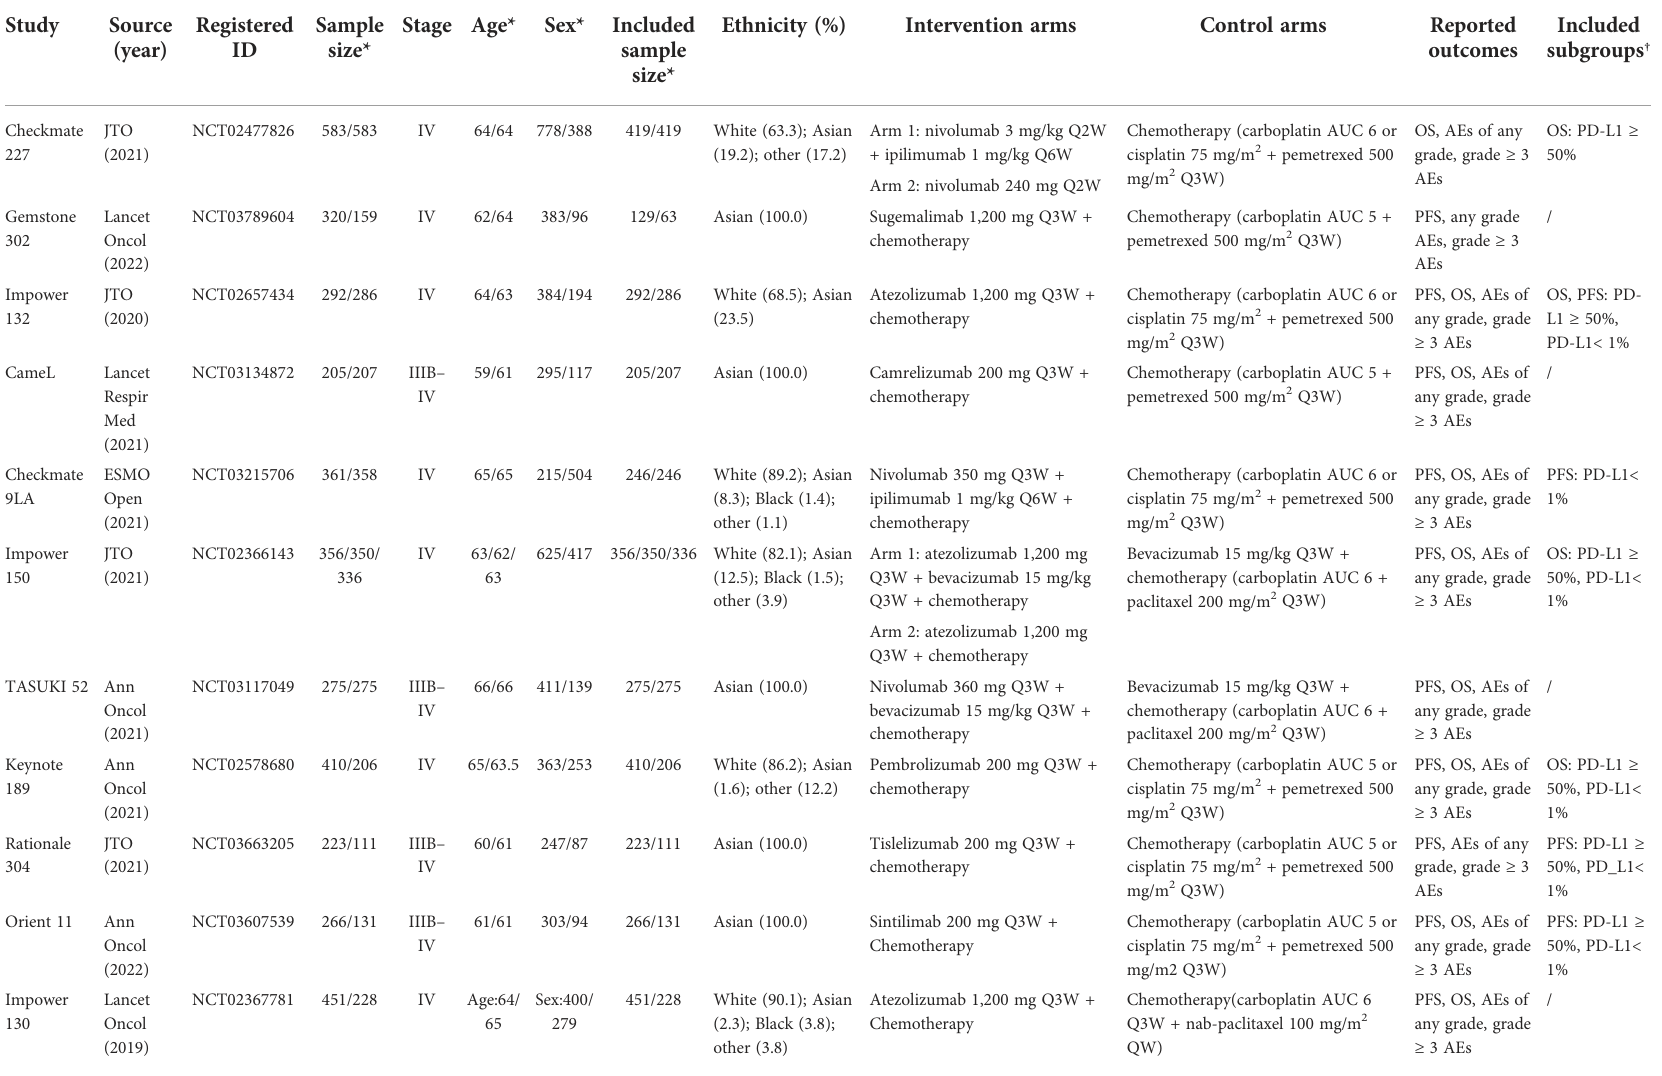
TABLE 1 Baseline characteristics of included